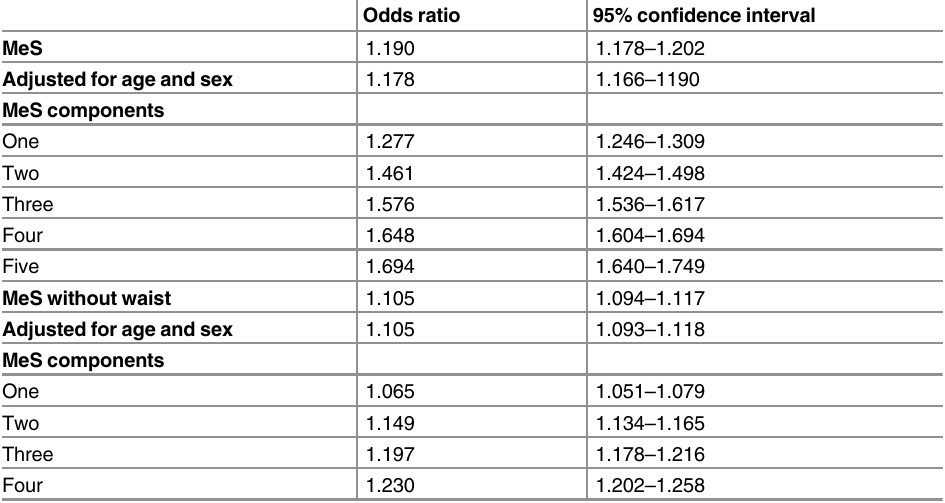
Table 3. Logistic regression model for the prediction of metabolic syndrome based on BMI * . Odds